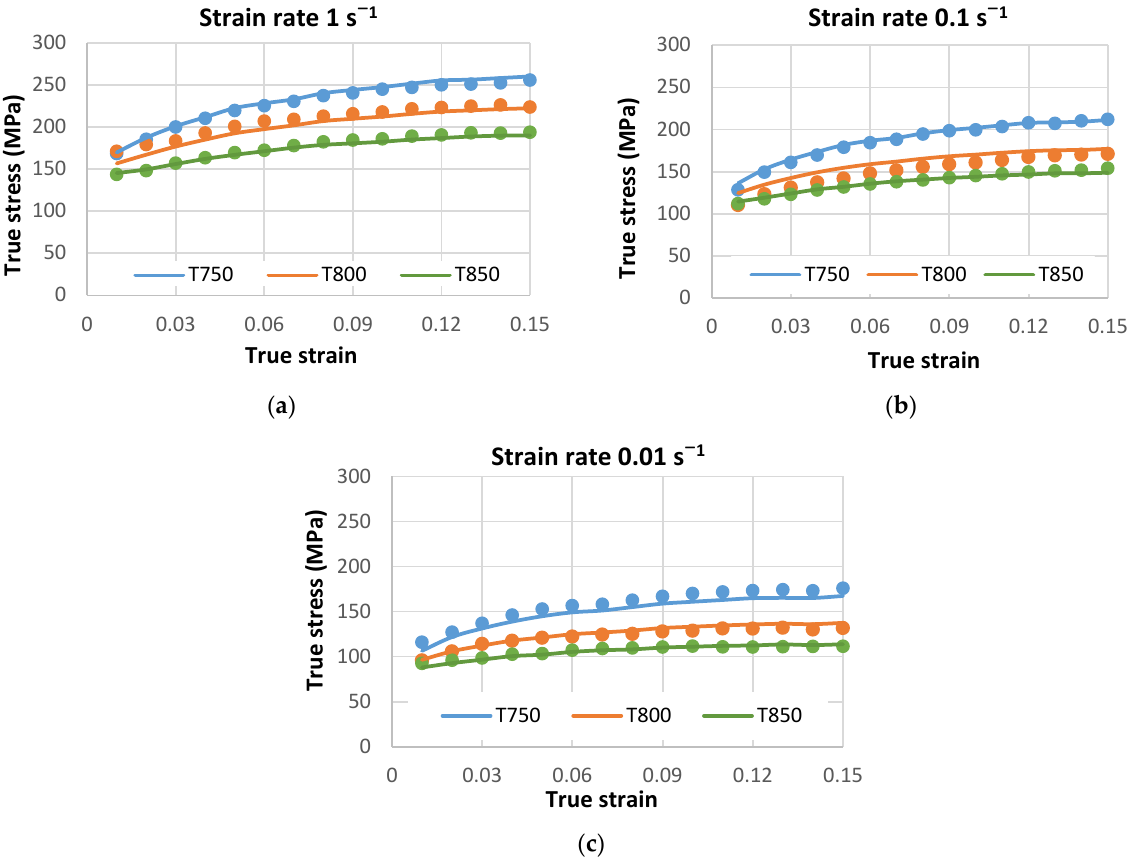
Figure 16. Comparison between experimental stress – strain curves (solid lines) and predicted stress – strain curves (circular markers) using the Arrhenius constitutive equation at various strain rates: ( a ) 1 s −1 , ( b ) 0.1 s −1 , and ( c ) 0.01 s −1 for the USIBOR ® 1500.